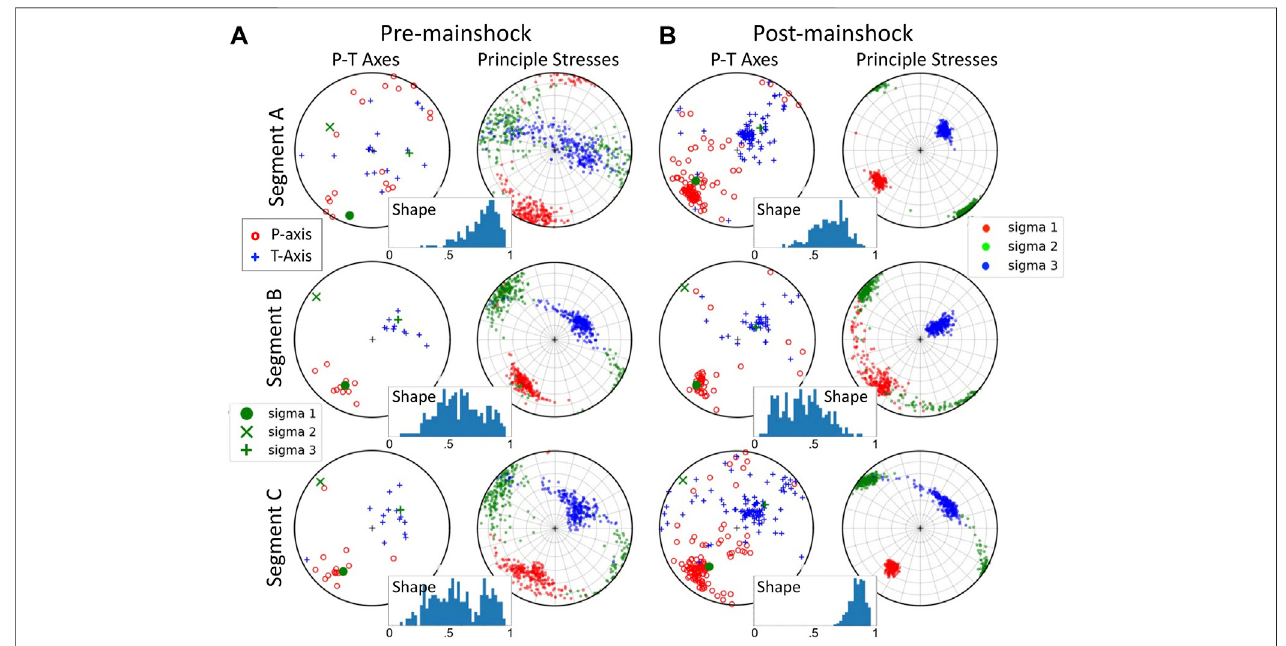
FIGURE 5 | Stress Inversion results for outer forearc segments A, B and C. Displayed are results for the pre- and post-mainshock stress fi eld (A) and (B) , respectively, in terms of P-T axes for individual focal mechanisms, principal stress axes, and shape factors. The uncertainty of principal stresses and shape ratios is estimated as half the 95% con fi dence intervals of bootstrap resampling